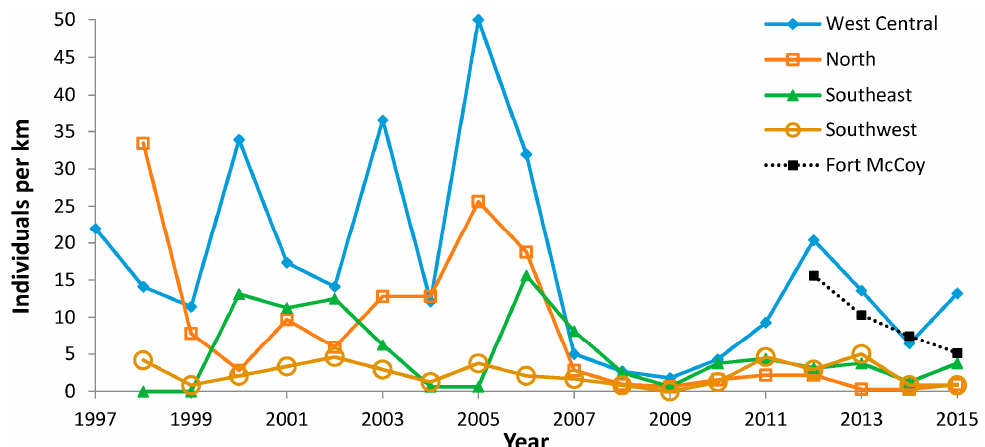
Figure 8. Regal fritillary individuals per km on peak survey per year at four areas of Buena Vista Grassland (West Central, North, Southeast, Southwest) and Fort McCoy. The 2016 abundance index at Fort McCoy was 16.2.